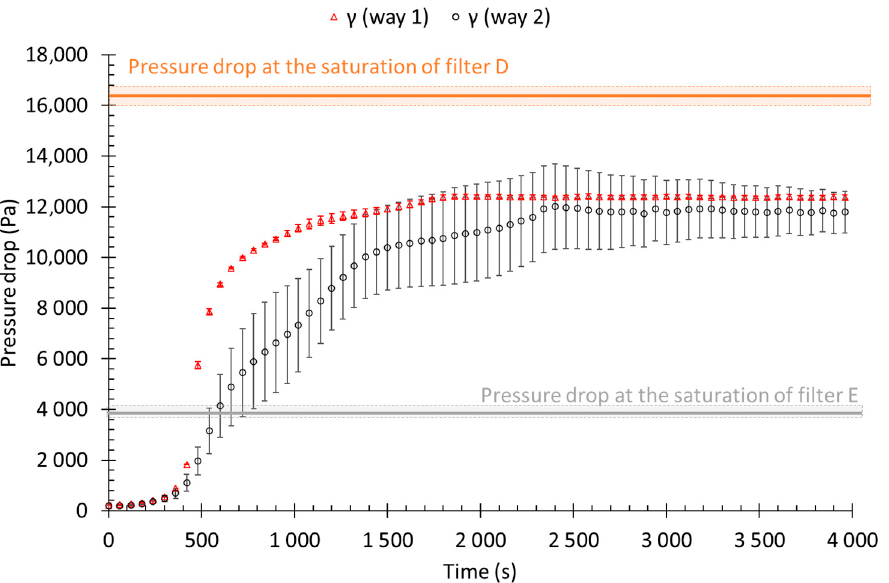
Figure 11. Pressure drop evolution as a function of the surface mass, for a multilayer filter and the associated layers at a filtration velocity of 6 cm/s.